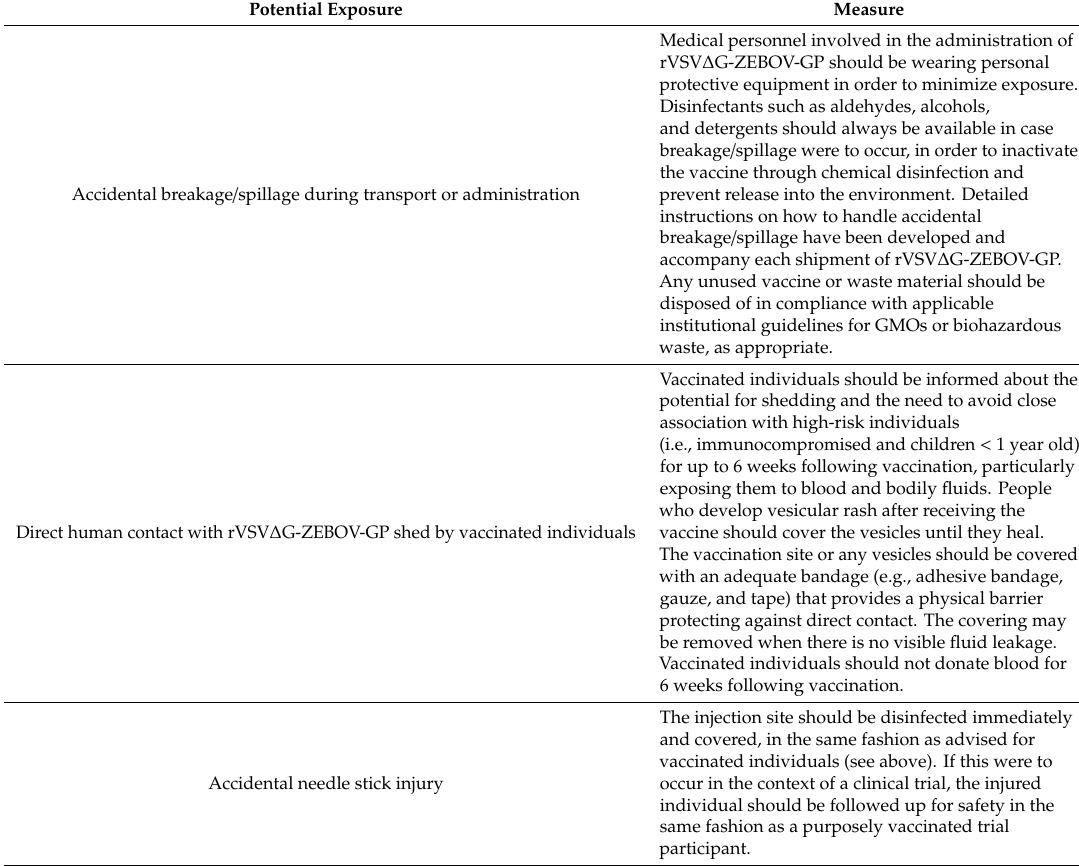
Table 3. Risk reduction measures recommended in the ERA to further reduce the potential human and environmental hazards associated with rVSV ∆